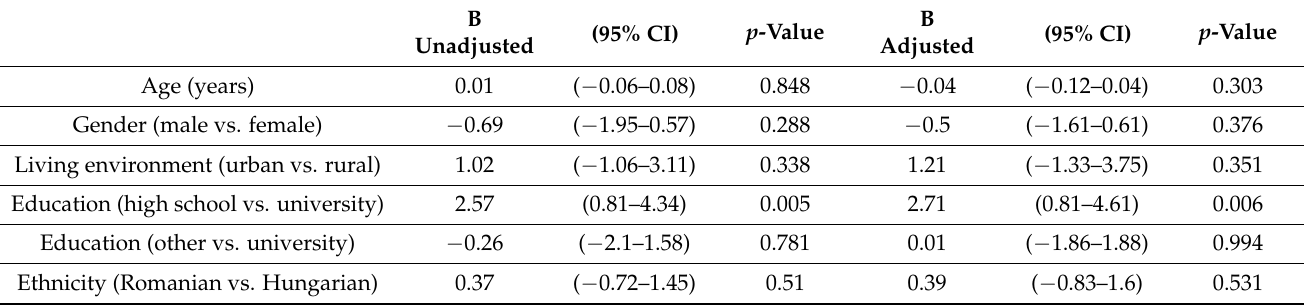
Table 5. Simple and multiple linear regression models predicting neuroticism score differences (pre-COVID-19 versus COVID-19